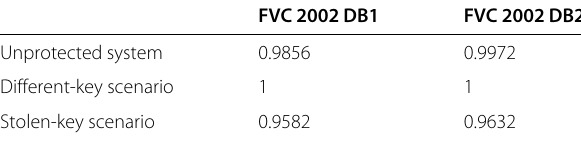
Table 2 The Kolmogorov–Smirnov tests for unprotected system, different-key, and stolen-key scenarios on FVC 2002 DB1 and DB2